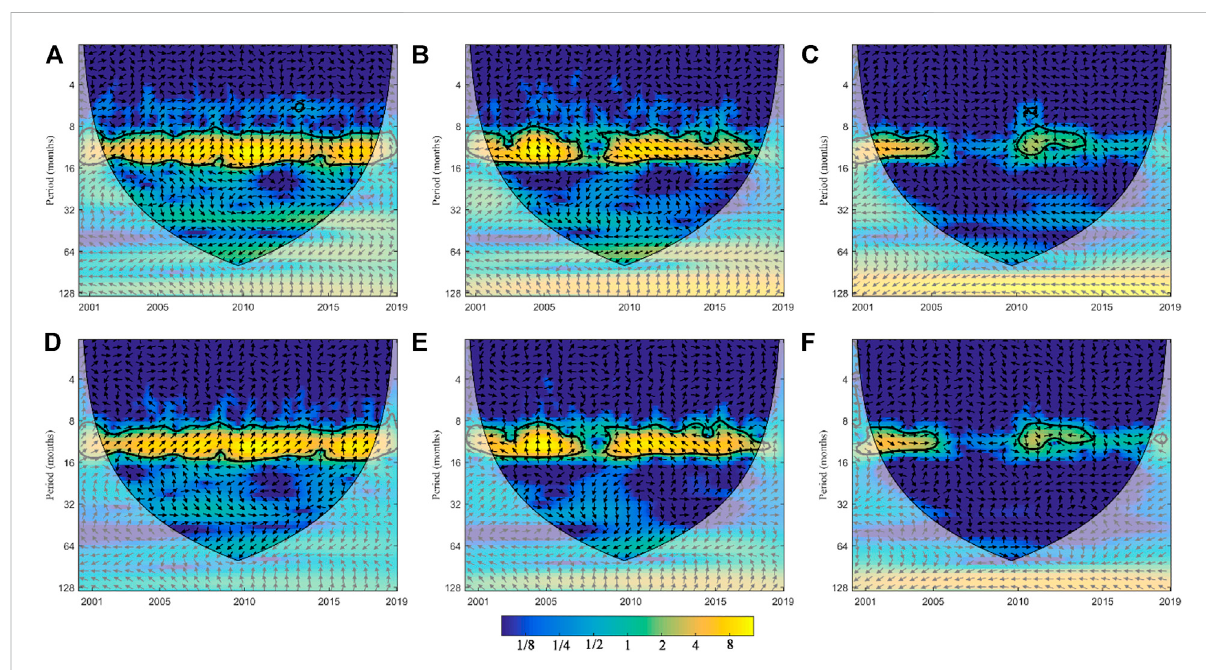
FIGURE 9 The XWT between monthly NDVI series (A – C) /SIF series (D – F) and large-scale climate patterns and solar activity in the